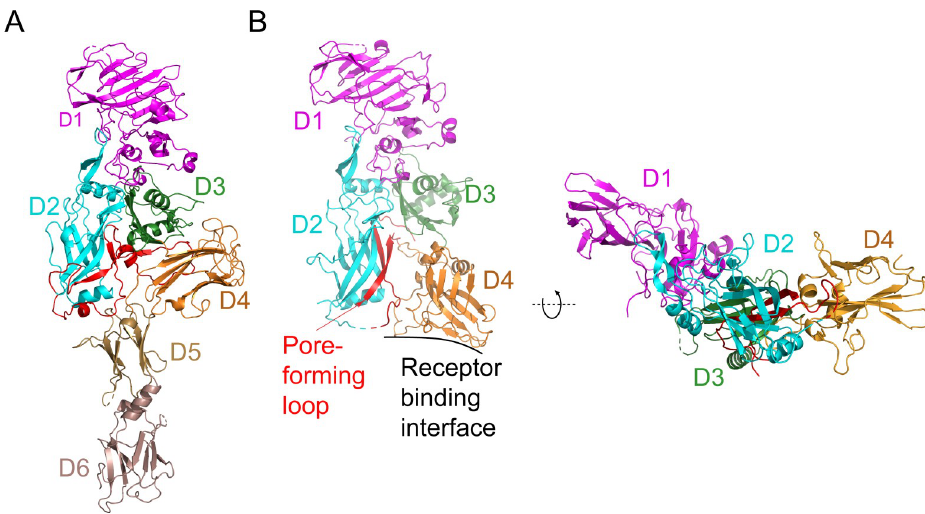
Fig 3. Structural comparison of Vpb4Da2 domains to corresponding domains of the Protective Antigen (PA). (A) Unique to Vpb4Da2, when compared to PA (PDB ID Acc1), are additional domains 5–6 found at the carboxyl- terminus. Moreover, Vpb4Da2 domain 4 displays a distinct topology. (B) Domains 1–3 of both proteins exhibit similar structural organization. The receptor binding interface and pore forming loop of PA are indicated.